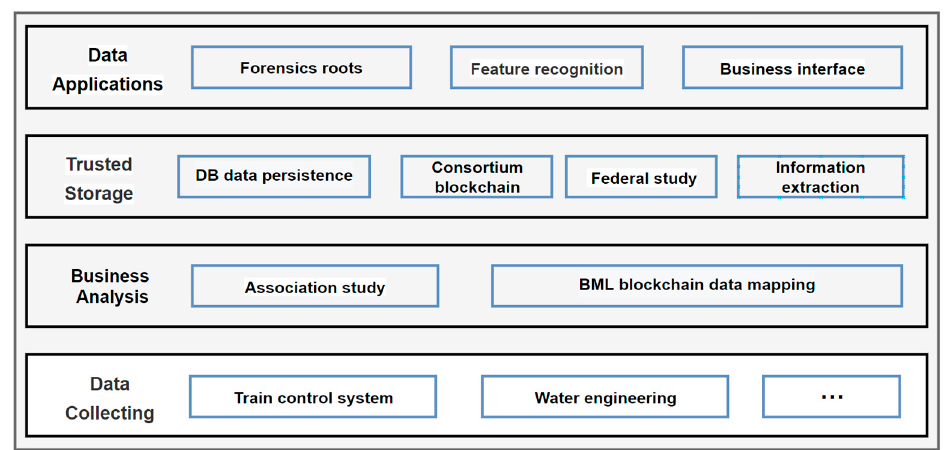
Figure 1. System architecture diagram.